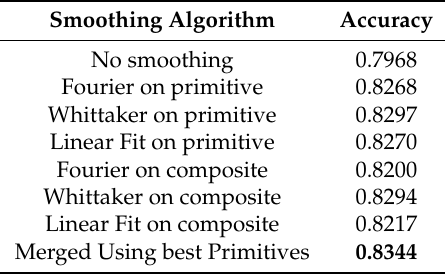
Comparison of overall land cover time-series accuracy using different approaches of